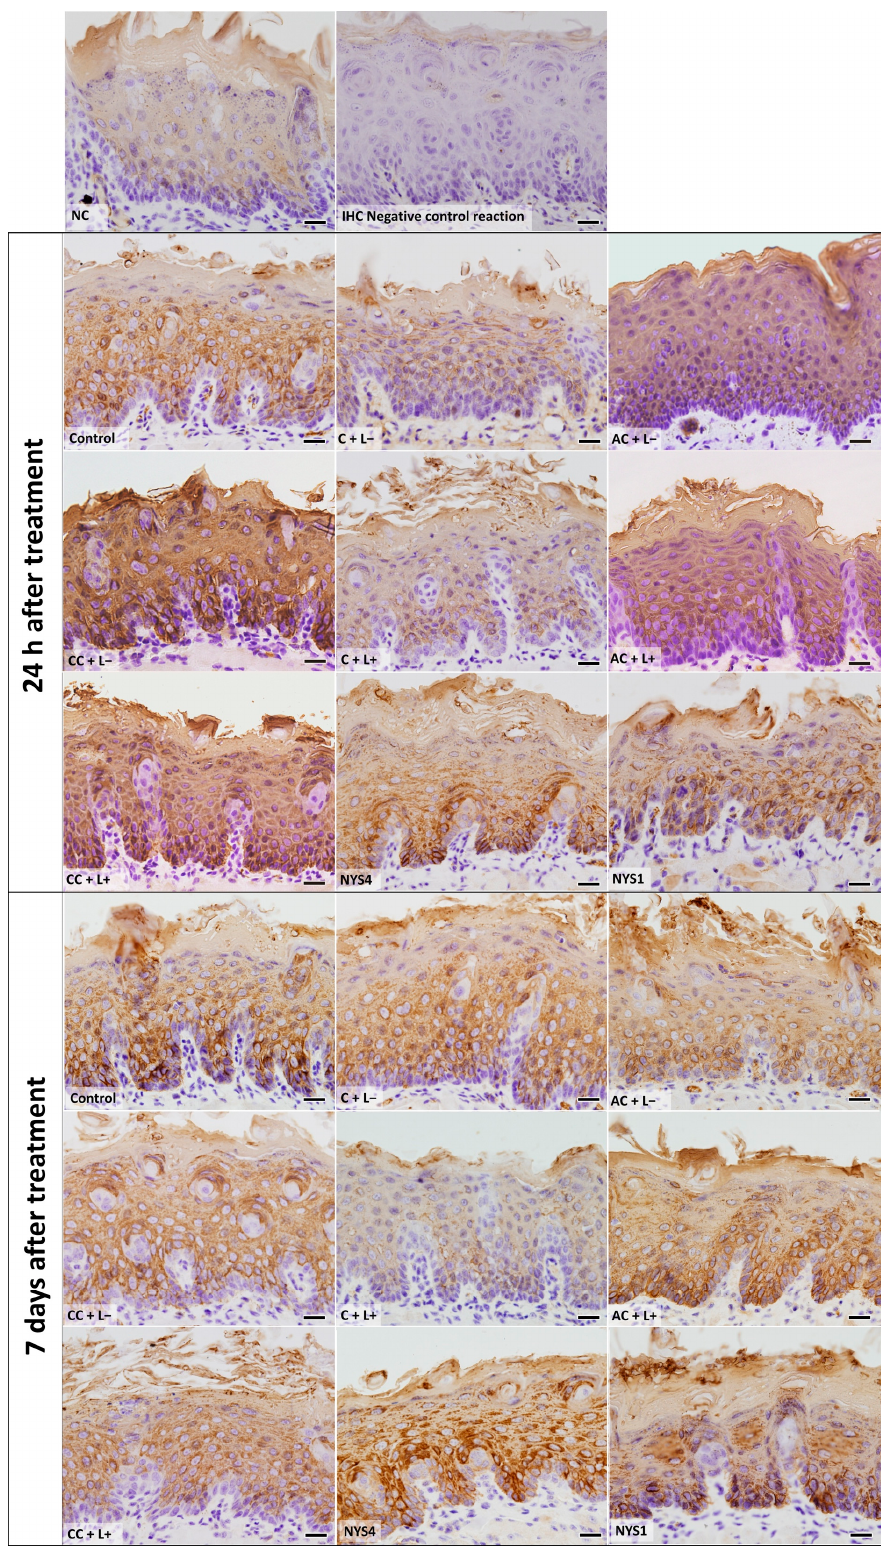
Figure 9. Light micrographs showing portions of sections of the tongue dorsal mucosa submitted to IHC for CK13 detection and counterstained with haematoxylin. NC group: healthy and untreated animals; Control group: infected animals that did not receive any treatment (C − L − ); C + L+, AC + L+, and CC + L+ groups: animals treated with aPDT mediated by free CUR, anionic and cationic CUR-NP, respectively, and blue LED light; C + L − , AC + L − , and CC + L − groups: evaluation of each PS alone (free CUR, and anionic and cationic CUR-NP, respectively); NYS1 and NYS4 groups: